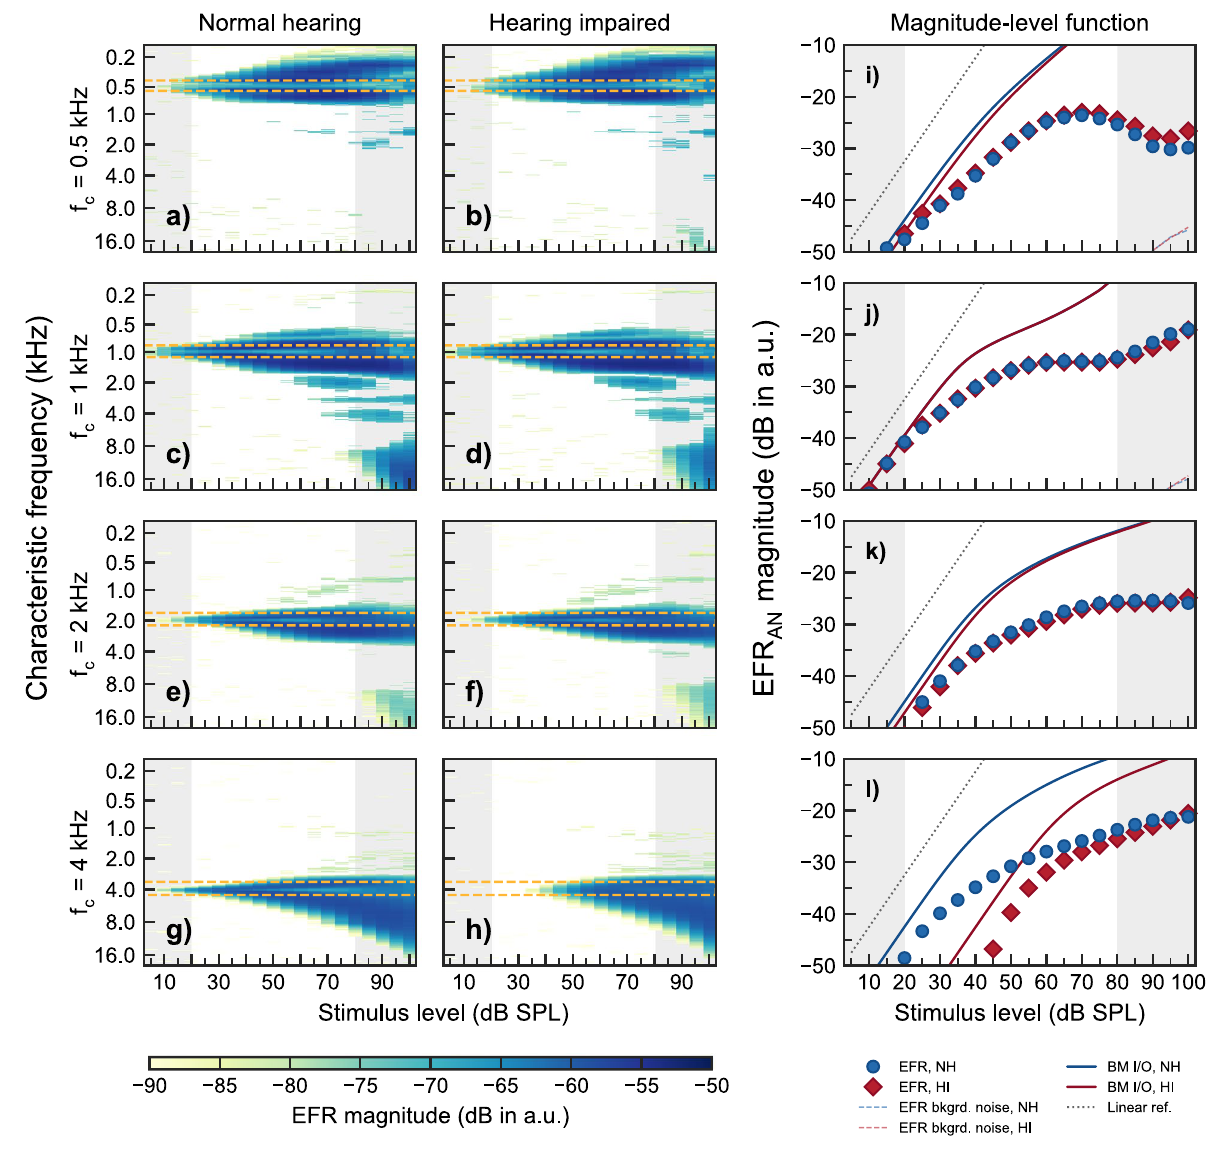
Figure 5. Simulated EFRs at the level of the AN ( EFR AN ) obtained with four simultaneously presented SAM tones as the ones used in the experiments. Panels ( a – h ) show EFR AN magnitudes as a function of stimulus levels and CF for each of the four carrier frequencies (rows). The colour gradient indicate significant EFR AN magnitudes. The horizontal orange dashed lines indicate the on-CF range as defined in 15 . The vertical grey shaded areas show input level ranges outside the level ranges considered in the experiments. The two leftmost columns show simulated EFR AN for the mean audiogram of the NH (left) and HI listeners (middle), respectively. Panels ( i – j ) in the rightmost column show the corresponding EFR AN magnitude-level functions obtained by summing up all AN activity across CF. Blue circles show NH simulations and red diamonds represent HI simulations. The thin blue and red dotted lines represent noise floor estimates (only visible in panels ( i , j ). The blue and red solid lines show BM I/O functions from the BM output of the model for NH and HI, respectively. The black dotted lines show a linear reference. A combination of IHC dysfunction 5,79 was assumed to adjust the AN model parameters to account for the mean audiogram values in each listener’s